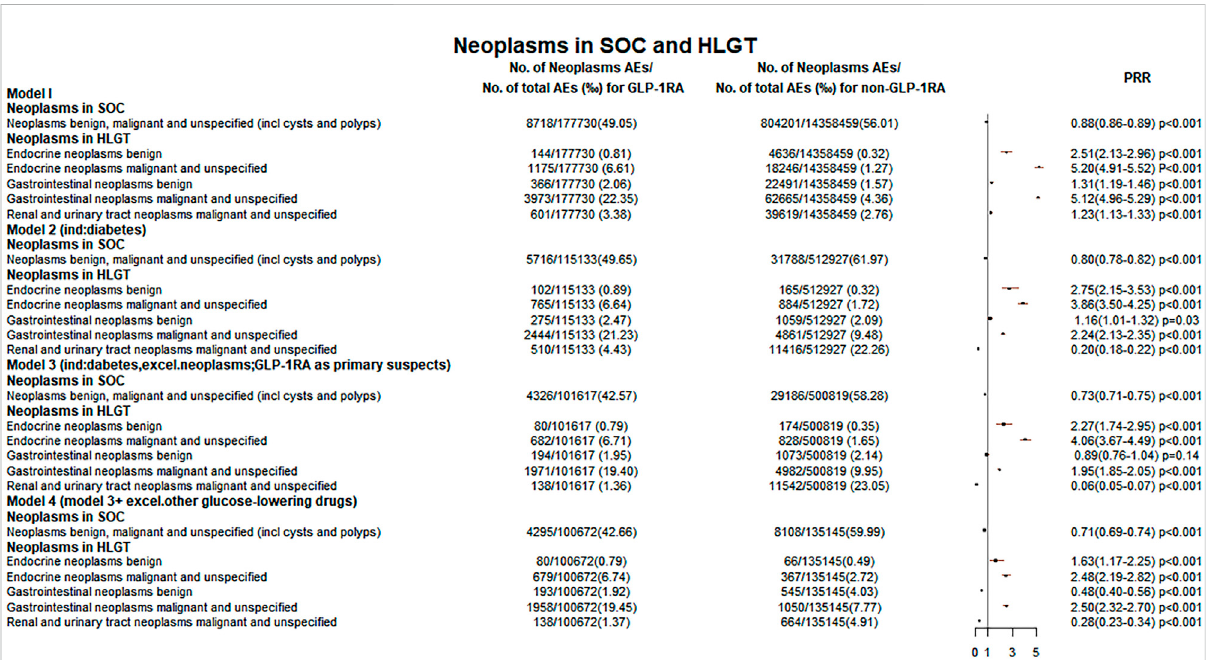
FIGURE 1 Neoplasm reporting rate at the SOC and HLGT levels. The reporting rates of GLP-1RA-associated neoplasms were compared with different comparatorsinfour models: 1)otherdrugs excludingGLP-1RA (non-GLP-1RA) without indication restrictions;2)non-GLP-1RAwhen diabetes asan indication;3)non-GLP-1RAwhentheindication islimitedtodiabeteswhileexcludingalltumors,andallcaseswithGLP-1RAasthe “ primarysuspect ” drug; and 4) all cases combining other glucose-lowering drugs were excluded on the basis of model 3 for